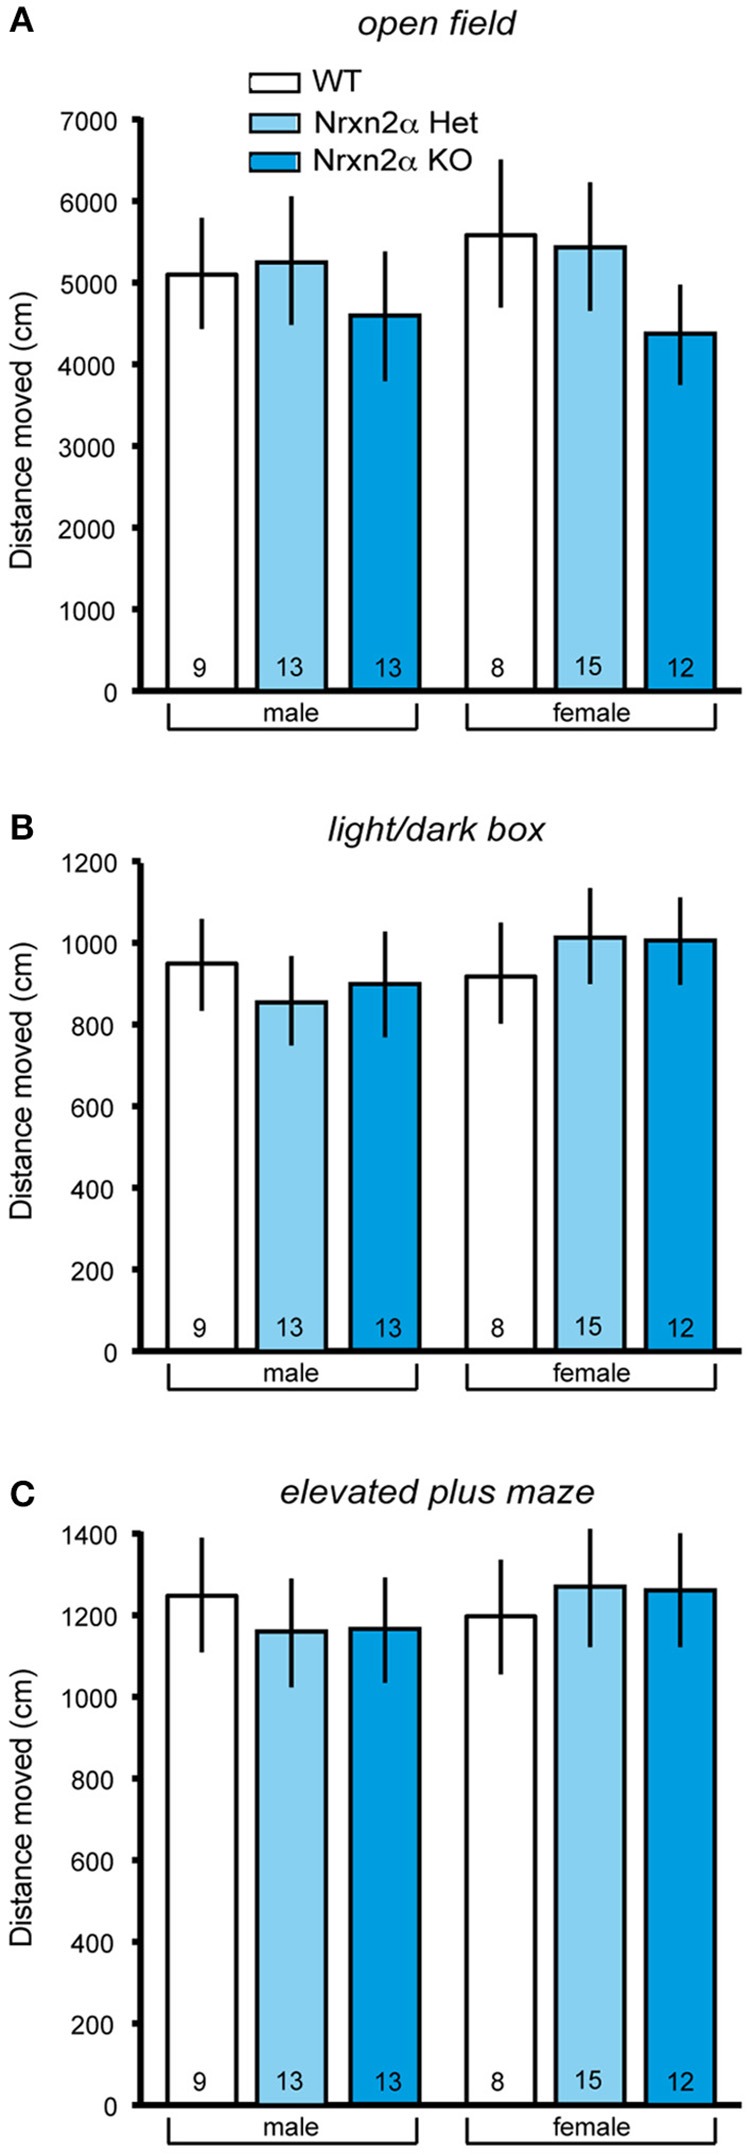
Locomotor activity measures of Nrxn2α-deficient mice. Locomotor activity was measured in the open field, light/dark box and elevated plus maze. (A) Distance (cm) traveled in the outer zone of the open field (left pair of bars) and female mice (right pair of bars), respectively. (B) Distance (cm) traveled in the dark compartment of the light/dark box (left pair of bars) and female mice (right pair of bars), respectively. (C) Distance (cm) traveled in the closed arms of the elevated plus maze (left pair of bars) and female mice (right pair of bars), respectively. Data shown are mean (± SEM) and derived from 17 WT (white bars, 9♂, 8♀), 28 HET (light blue bars, 13♂, 15♀), and 25 Nrxn2α KO mice (blue squares, 13♂, 12♀).